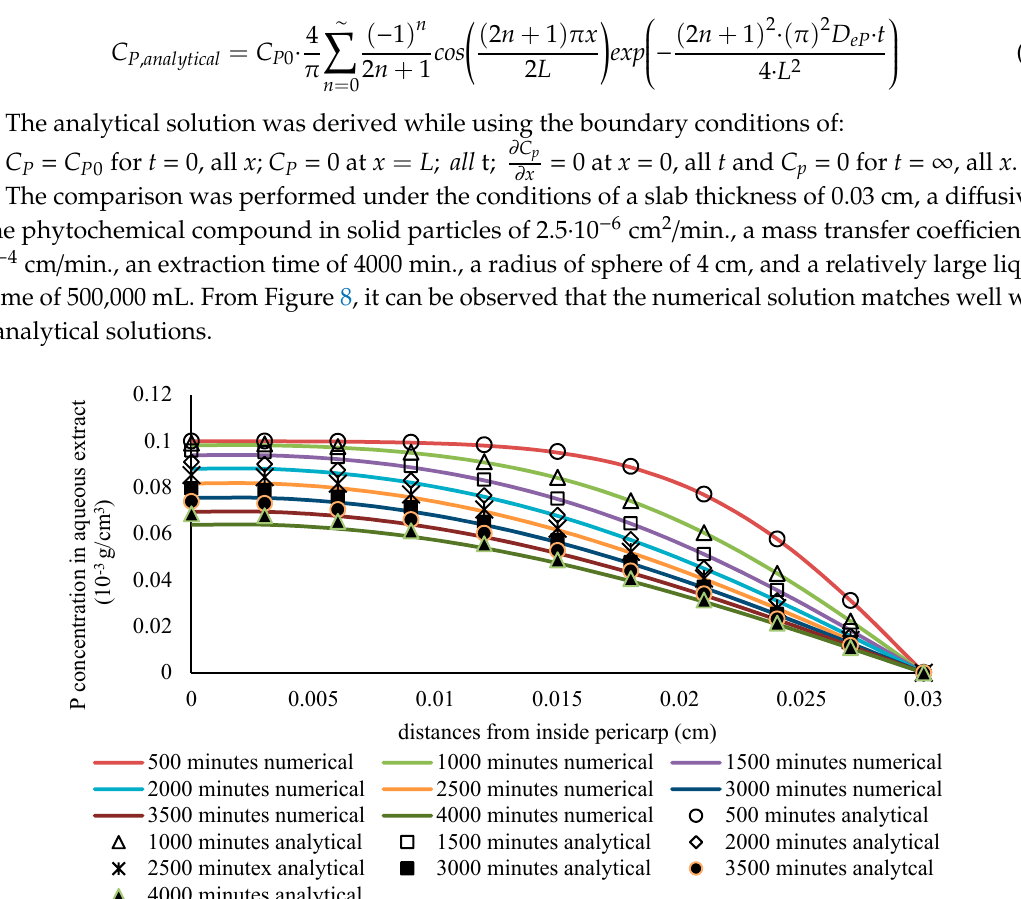
Figure 8. The comparison of the analytical solution and the numerical solution under the conditions of a constant phytochemical concentration in the solvent and very slow diffusion.